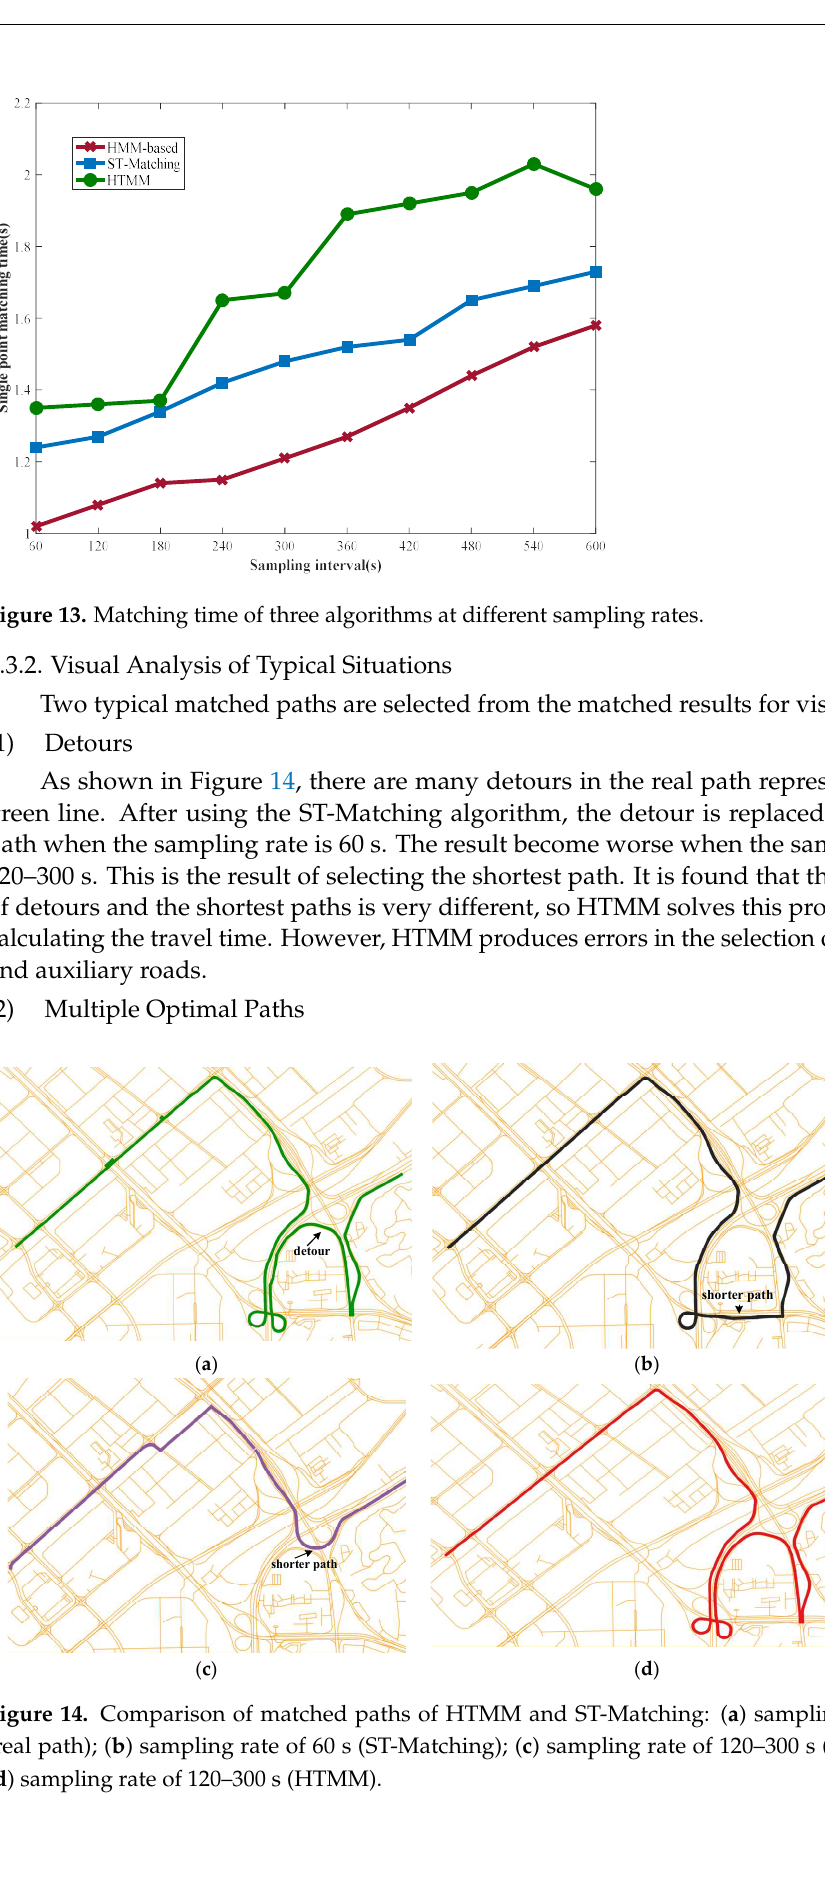
( c ) Figure 15. Comparison of matched paths of HTMM and ST-Matching: ( a ) sampling rate of 30 s (real path); ( b ) sampling rate of 60–300 s (ST-Matching); ( c ) sampling rate of 60–120 s (HTMM).